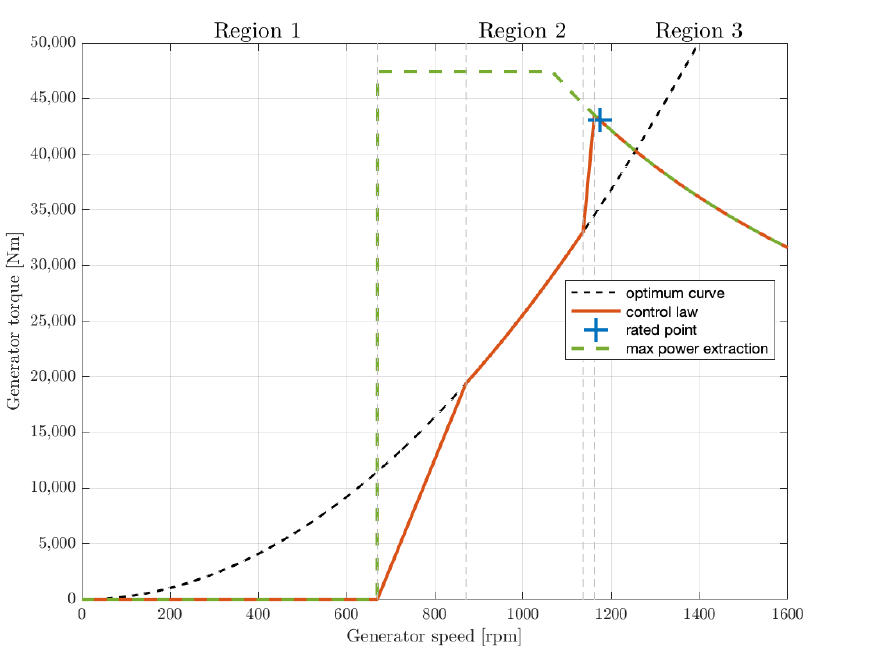
Figure 10. Generator-torque versus generator-speed control law and control regions. Blade-Pitch